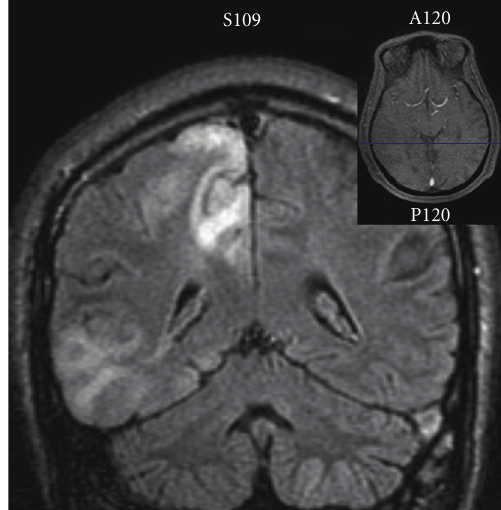
Figure 1: Visit 2 (09/2010) Coronal Flair MRI Image showing acute right para-sagital posterior temporo-parietal ischemic stroke.